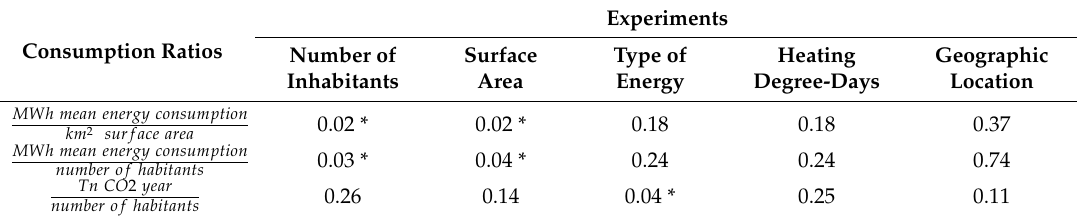
Table 3. Results for the p corresponding to the ANOVA for the average annual energy consumption for a 0.05 level of